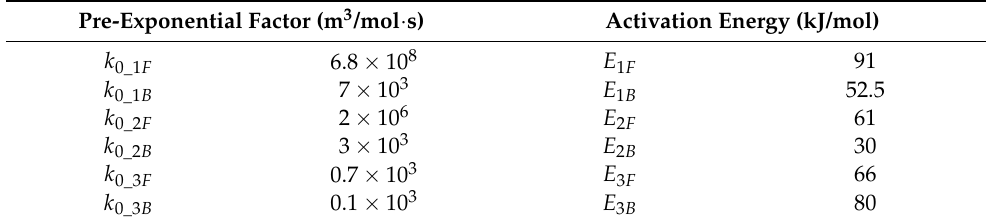
Table 4. Frequency factors ( k 0 ) and activation energies ( Ea ) of the kinetic